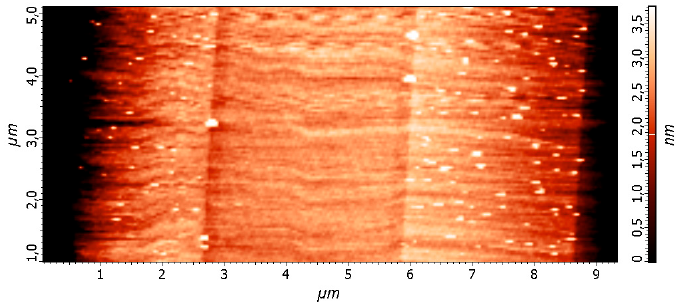
Figure 2. Topographic map for the cleaved facet of the GaAs/AlGaAs quantum cascade laser obtained in the tapping regime of AFM. The laser core is between ~3 and ~6 µm on the horizontal scale with 0.2 µm thick GaAs spacers and 3 µm wide AlInP claddings surrounding it on both sides. The GaAs substrate is on the right.